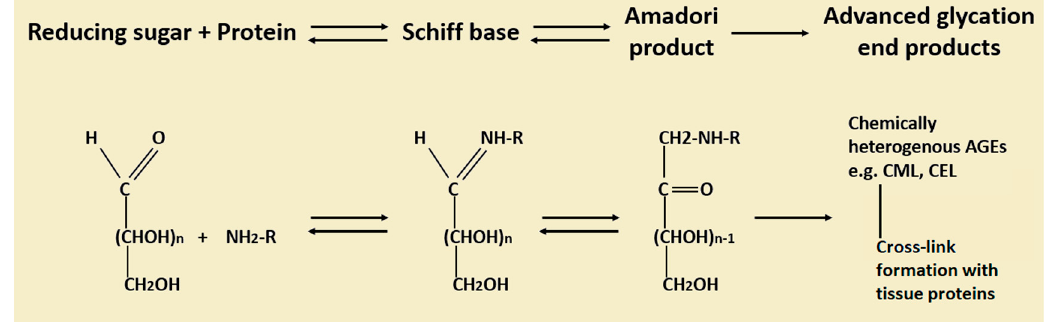
Figure 2. Structure and formation of advanced glycation end products. Formation of advanced glycation end products (AGEs) starts with a reversible reaction between reducing sugars and amino acids resulting in the formation of Schiff bases. Schiff bases then may undergo hydrolysis or rearrange into more stable Amadori products. Amadori products may undergo a further series of dehydration and rearrangements, forming AGEs (adapted from [14]).